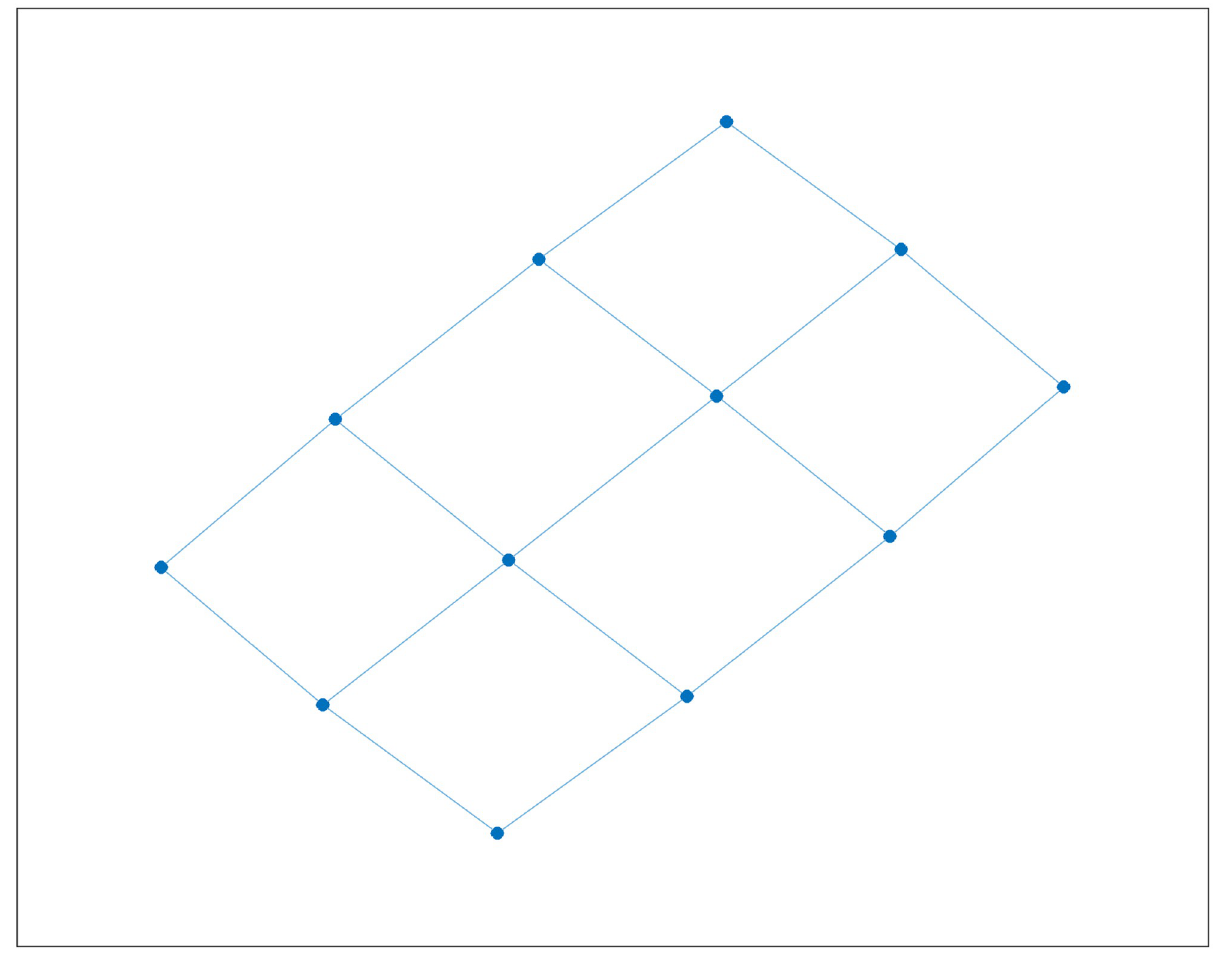
Fig 2. The graph L (3,